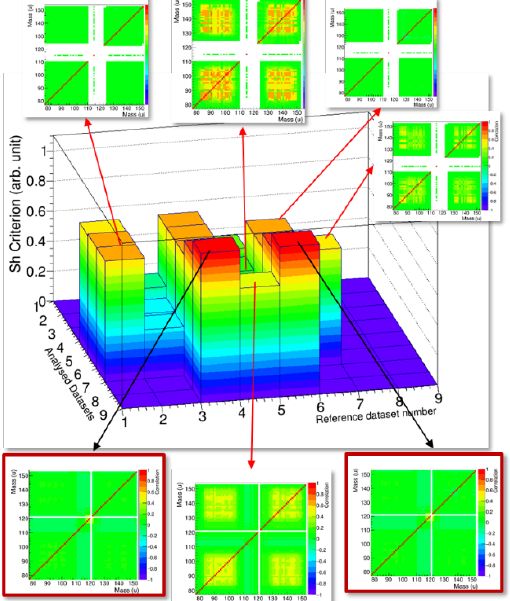
Fig. 14. Histogram of Shannon entropy criterion as a function of the reference dataset and the number of datasets used. The extrema are illustrated with different correlation matrices of evaluated mass yields (White bands correspond to the unevaluated mass